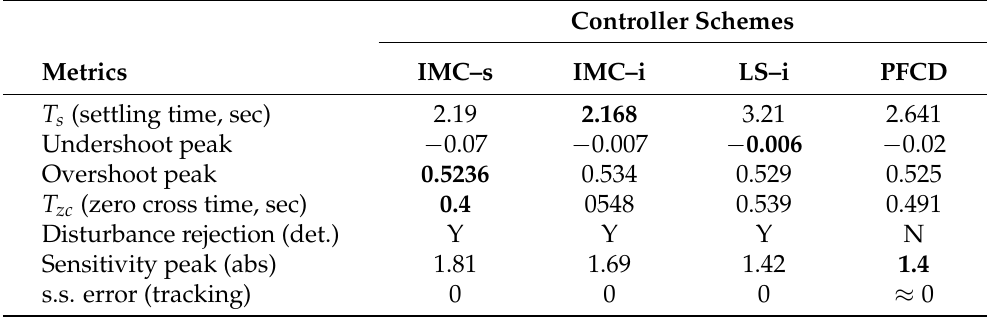
Table 2. Evaluation of controller schemes